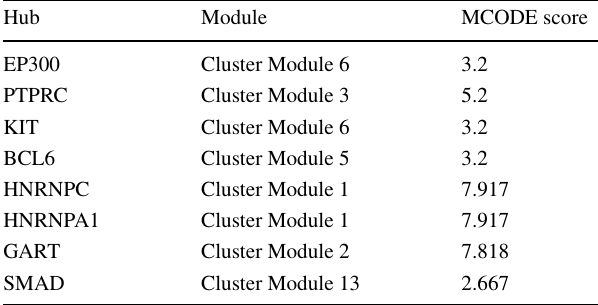
Table 2 Hub gene module